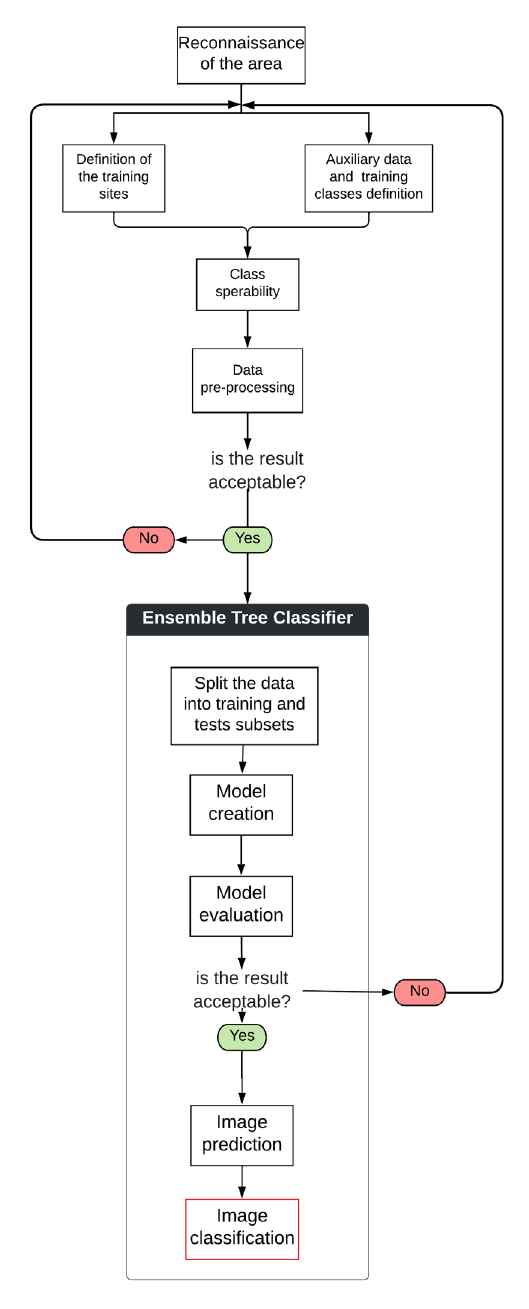
Figure 6. Workflow showing the step-by-step method applied to the RF algorithm.